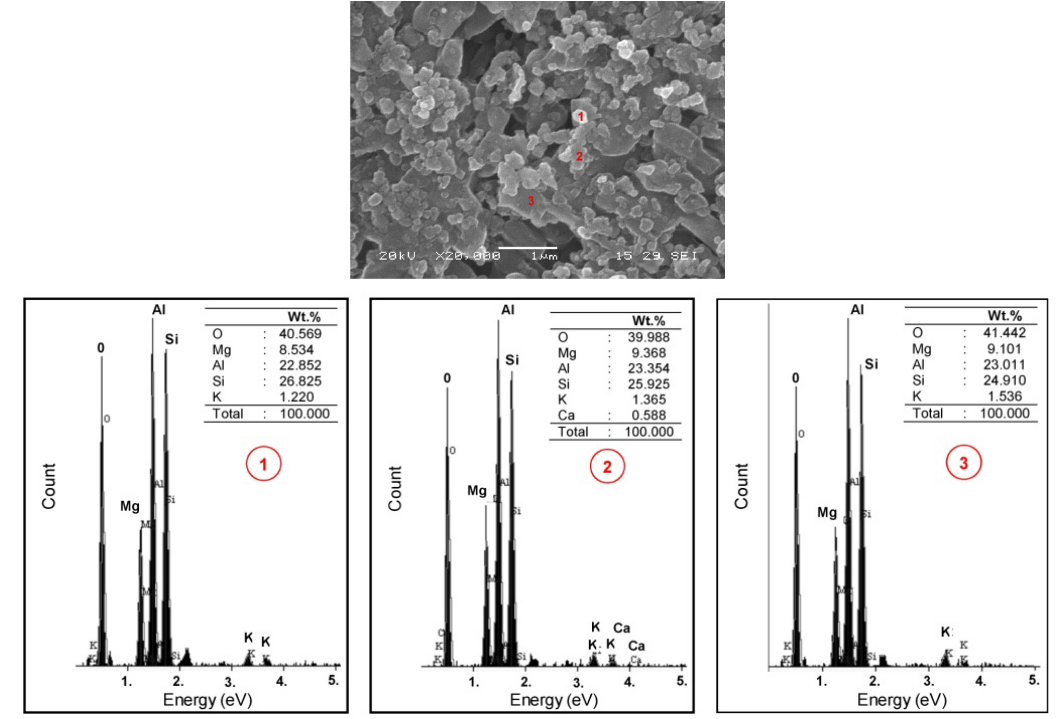
Fig. 10 SEM micrograph and EDS analysis of the samples sintered at 1250 ℃ for 1